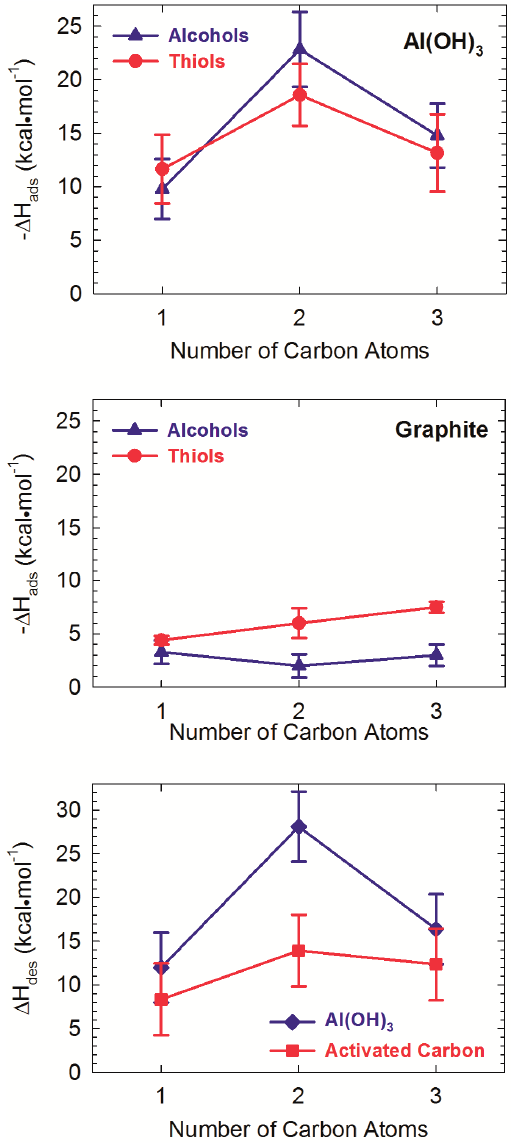
Figure 2. Adsorption enthalpy of C1–C3 alcohols and thiols on Al(OH) ( middle ); surfaces, compared with chemisorption experiments of alcohol adsorption ( bottom ). Reprinted with permission from [50]. Copyright 2012 American Chemical